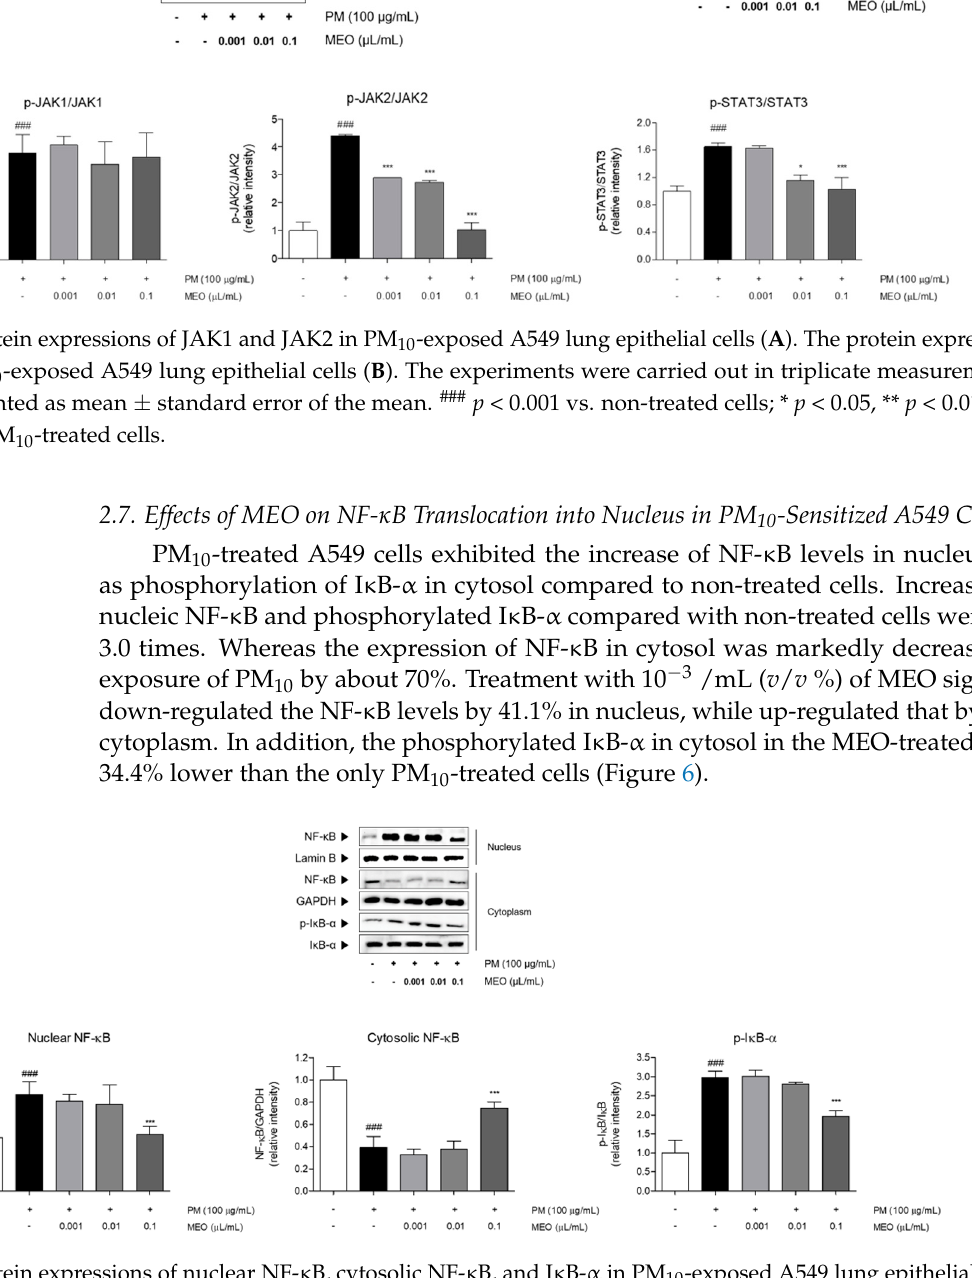
Figure 6. The protein expressions of nuclear NF- κ B, cytosolic NF- κ B, and I κ B- α in PM 10 -exposed A549 lung epithelial cells. The experiments were carried out in triplicate measurements. Results are presented as mean ± standard error of the mean. ### p < 0.001 vs. non-treated cells; * p < 0.05, ** p < 0.01 and *** p < 0.001 vs. PM 10 -treated cells.